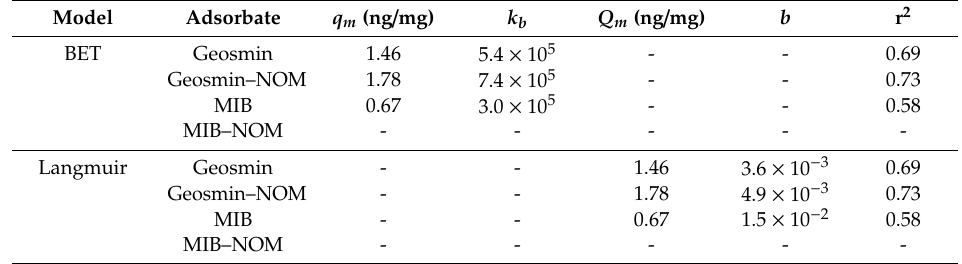
Figure 3. ( a ) Geosmin adsorption isotherms and ( b ) MIB adsorption isotherms on GO in the absence and presence of NOM. The range of GO concentrations was 100–500 mg / L, while the NOM concentration was 2.3 mg C / L, the initial concentrations of geosmin and MIB were ~1 µ g / L, and the initial pH was between 7.3 and 7.5. The solid lines are predictions calculated using the Langmuir adsorption isotherm model. Table 2. q m , k b , Q m , b , and r 2 values in the Brunauer–Emmett–Teller (BET) and Langmuir isotherm models.